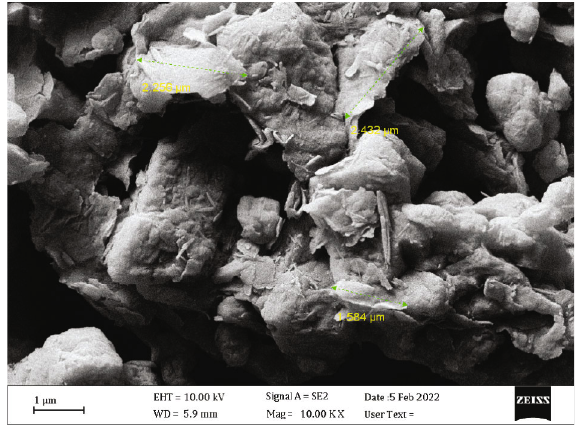
Figure 3: FESEM micrograph for